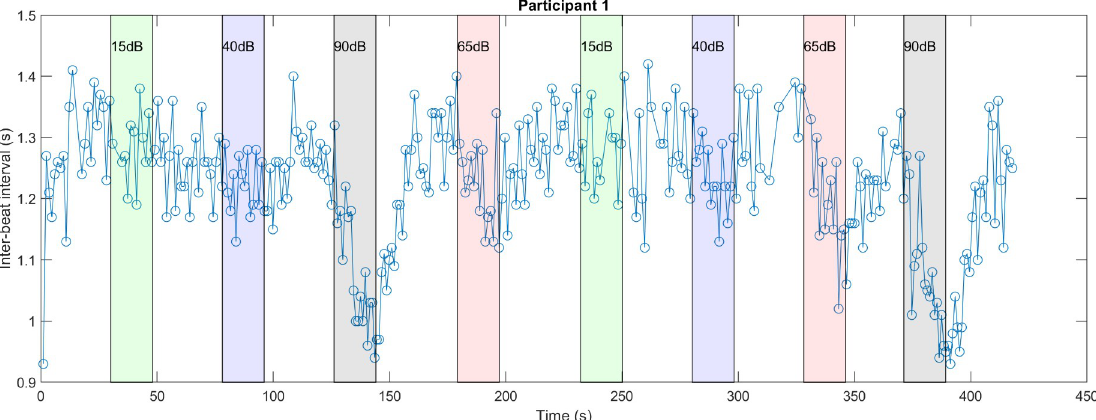
Fig 3. Inter-beat intervals across time for a representative participant. Vertical lines show the times sound stimuli at different levels were applied.